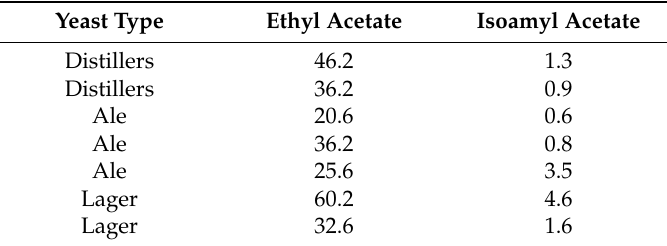
Table 5. Ethyl acetate and isoamyl acid (mg/L) produced by distillers and brewer’s yeast strains